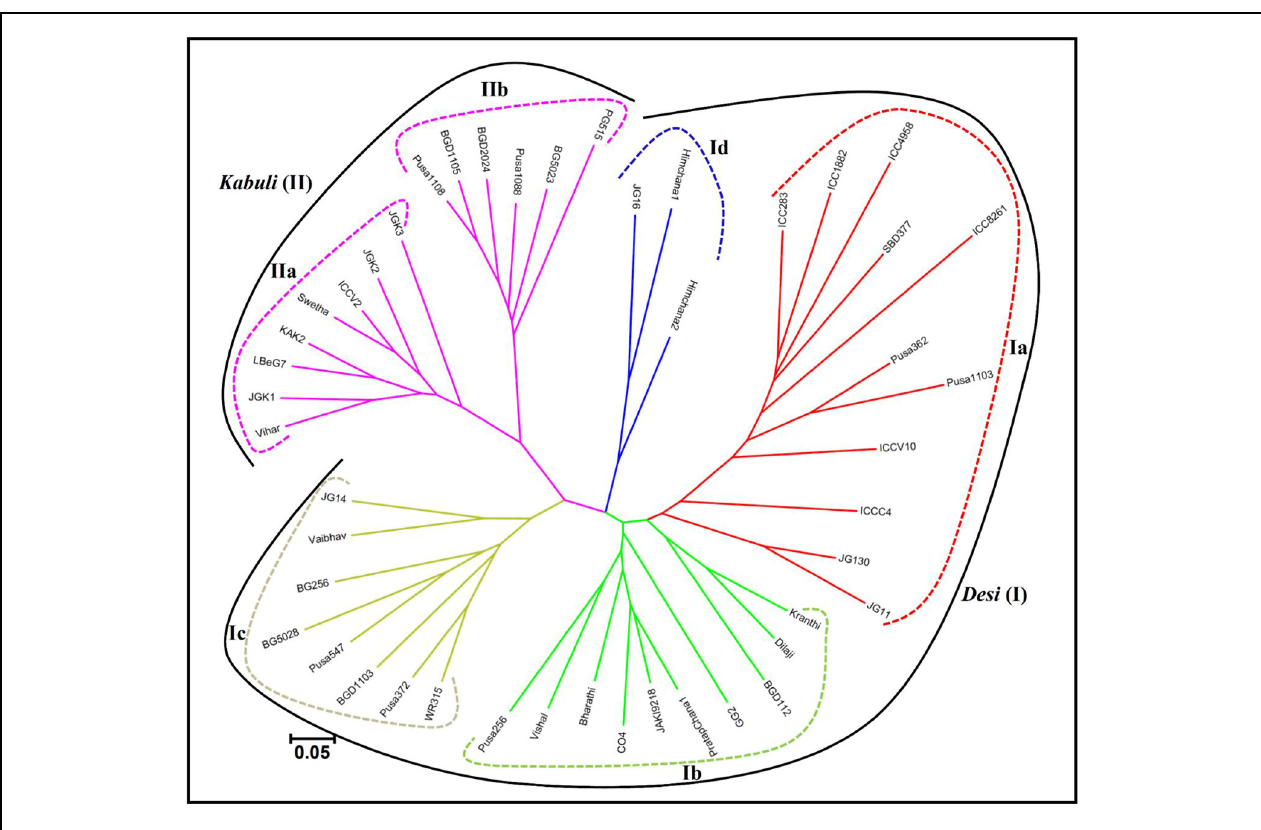
FIGURE 6 | Unrooted phylogenetic tree depicting the genetic relationships among desi and kabuli genotypes. The tree was generated based on Nei’s genetic distance using genotyping data of 160 informative SSR